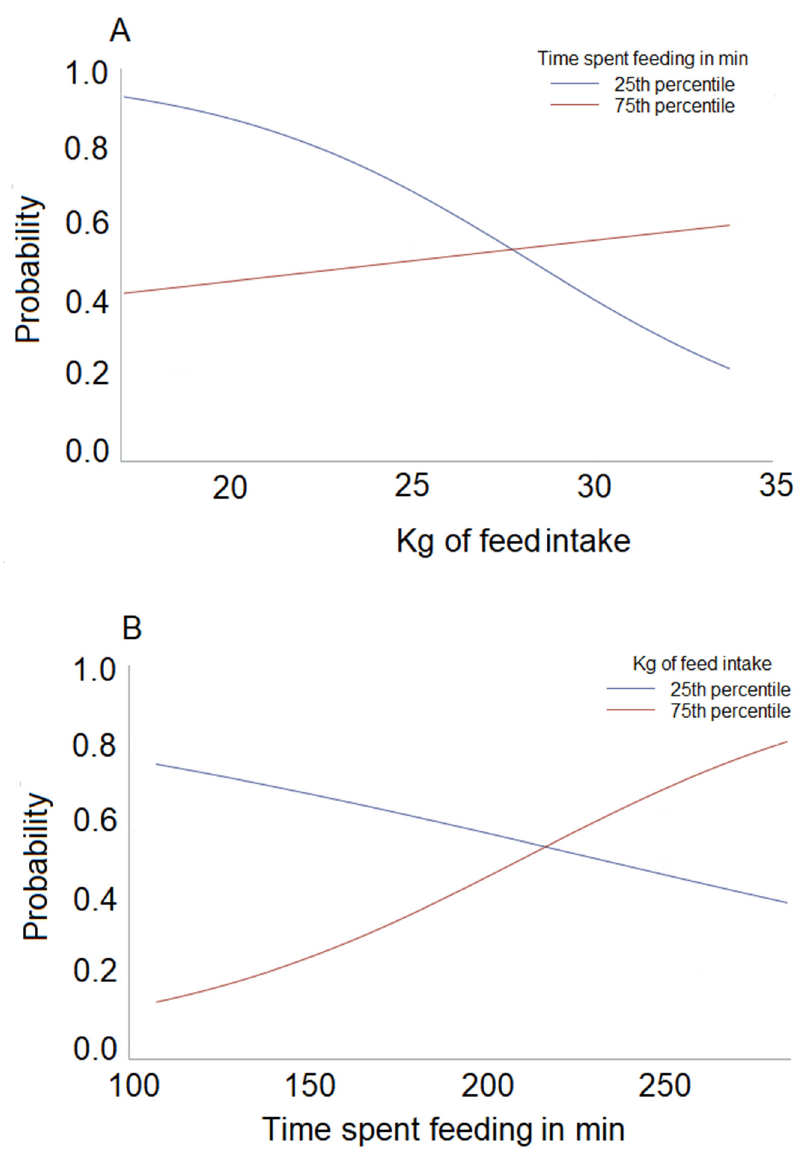
Figure 1. Panel ( A ) shows the predicted probabilities for postpartum disease in primiparous animals on the Y-axis and feed intake on the X-axis. The solid blue line represents a primiparous cow that spent 185 min feeding (i.e., the 25th percentile), and the red line represents a primiparous cow that spent 222 min of feeding (i.e., the 75th percentile). Panel ( B ) shows the predicted probabilities for postpartum disease in primiparous animals on the Y-axis and time spent feeding on the X-axis. The solid blue line represents a primiparous cow that consumed 26.6 kg of feed (i.e., the 25th percentile), and the red line represents a primiparous cow that consumed 30.3 kg (i.e., the 75th percentile). For both panels, the variable bins per meal was held constant at the mean value of 5.02.